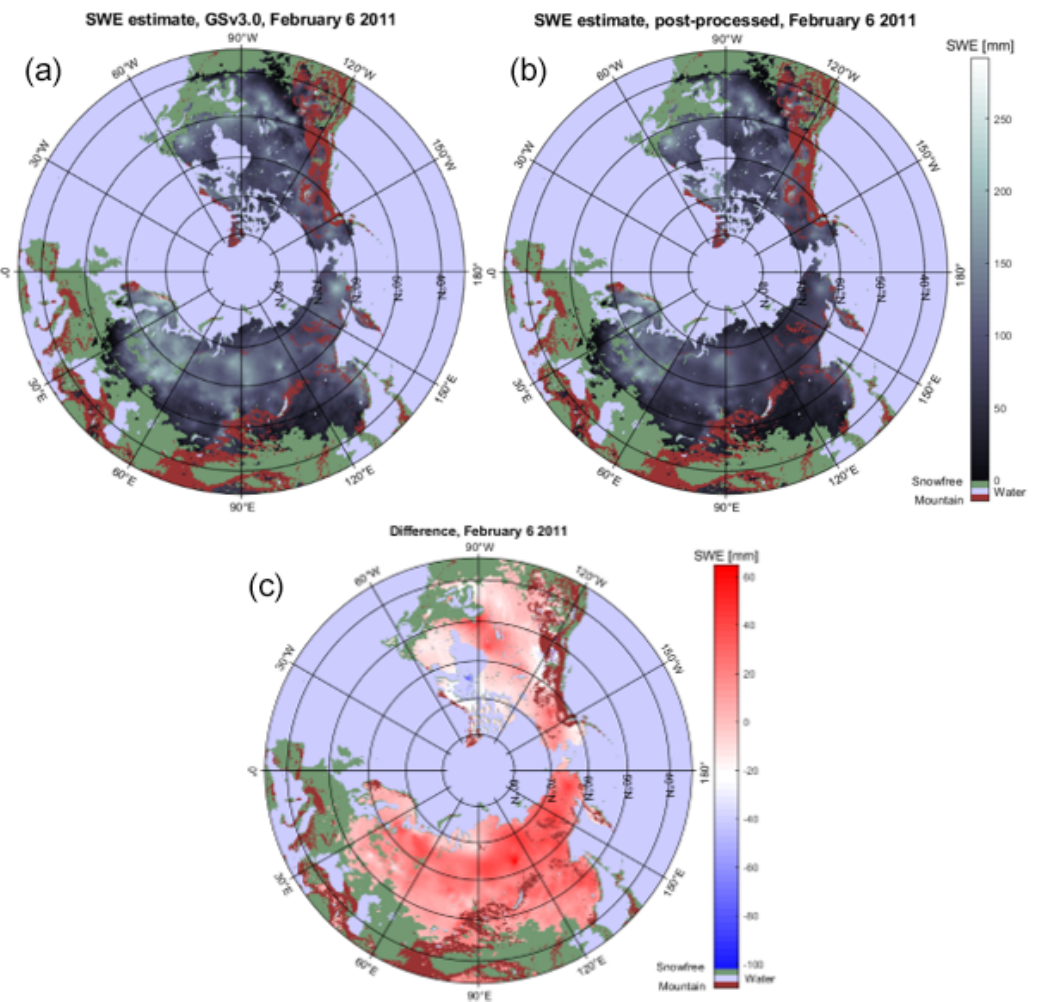
Figure 10. SWE maps for baseline GSv3.0 retrieval (a) , post-processed retrieval (b) , and difference between GSv3.0 and post-processed retrieval (post-processed subtracted from the baseline) for 6 February 2011. The post-processed SWE values are lower as overestimation of small SWE values is